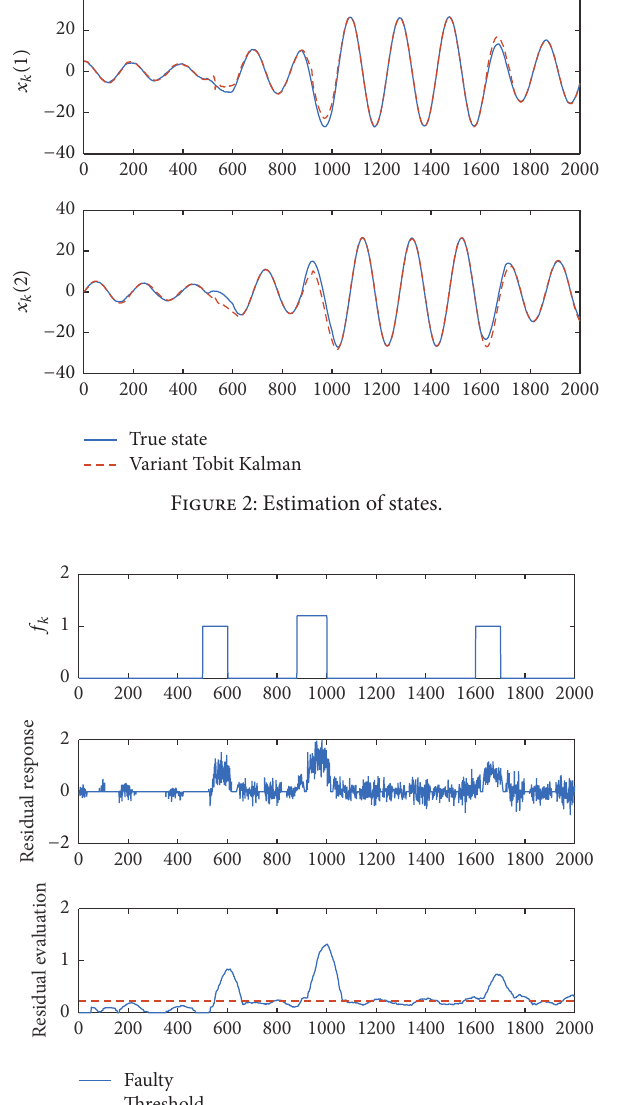
Figure 3: 𝑓 𝑘 , residual response and residual